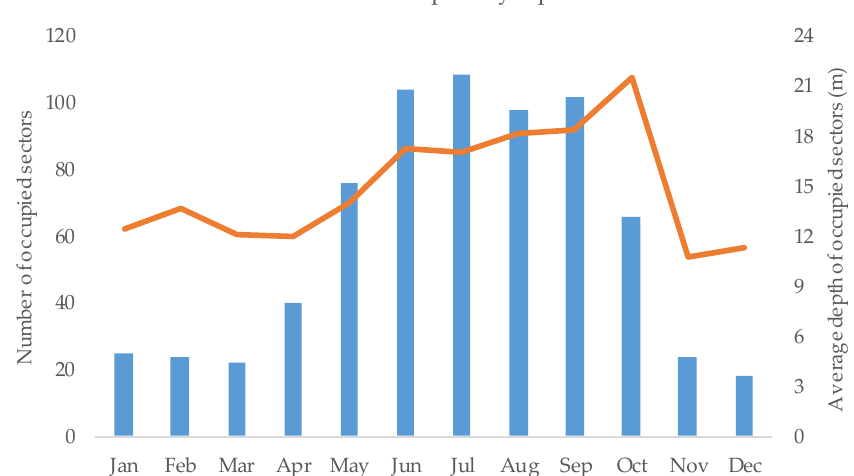
Figure 2. Number and distribution of occupied cave sectors. The plot shows the monthly number of cave sectors occupied by crane flies and their average depth (linear meters from the connection with surface).